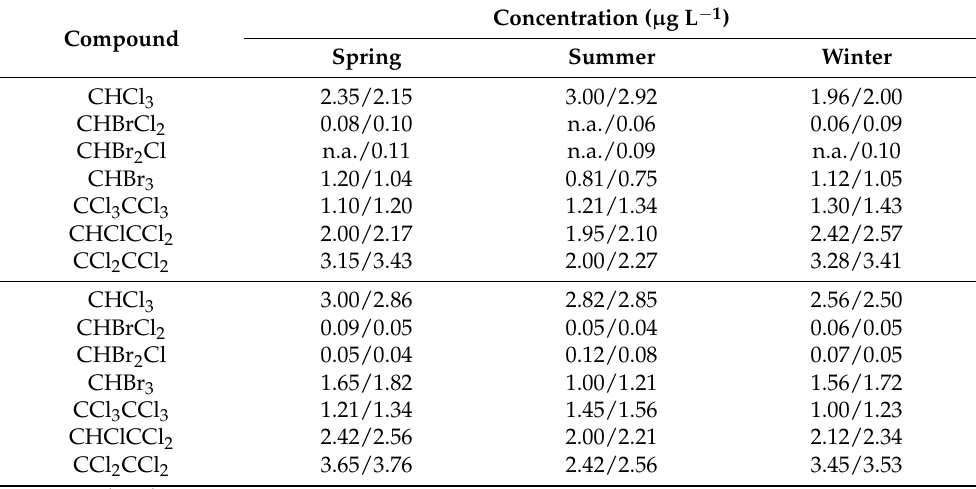
Table 4. Organohalogens in the Tiber samples (#24) during different seasons in 2015 and 2016. For each compound are reported the levels determined by the two analytical procedures (HS-GC- ECD/LL-GC-ECD).